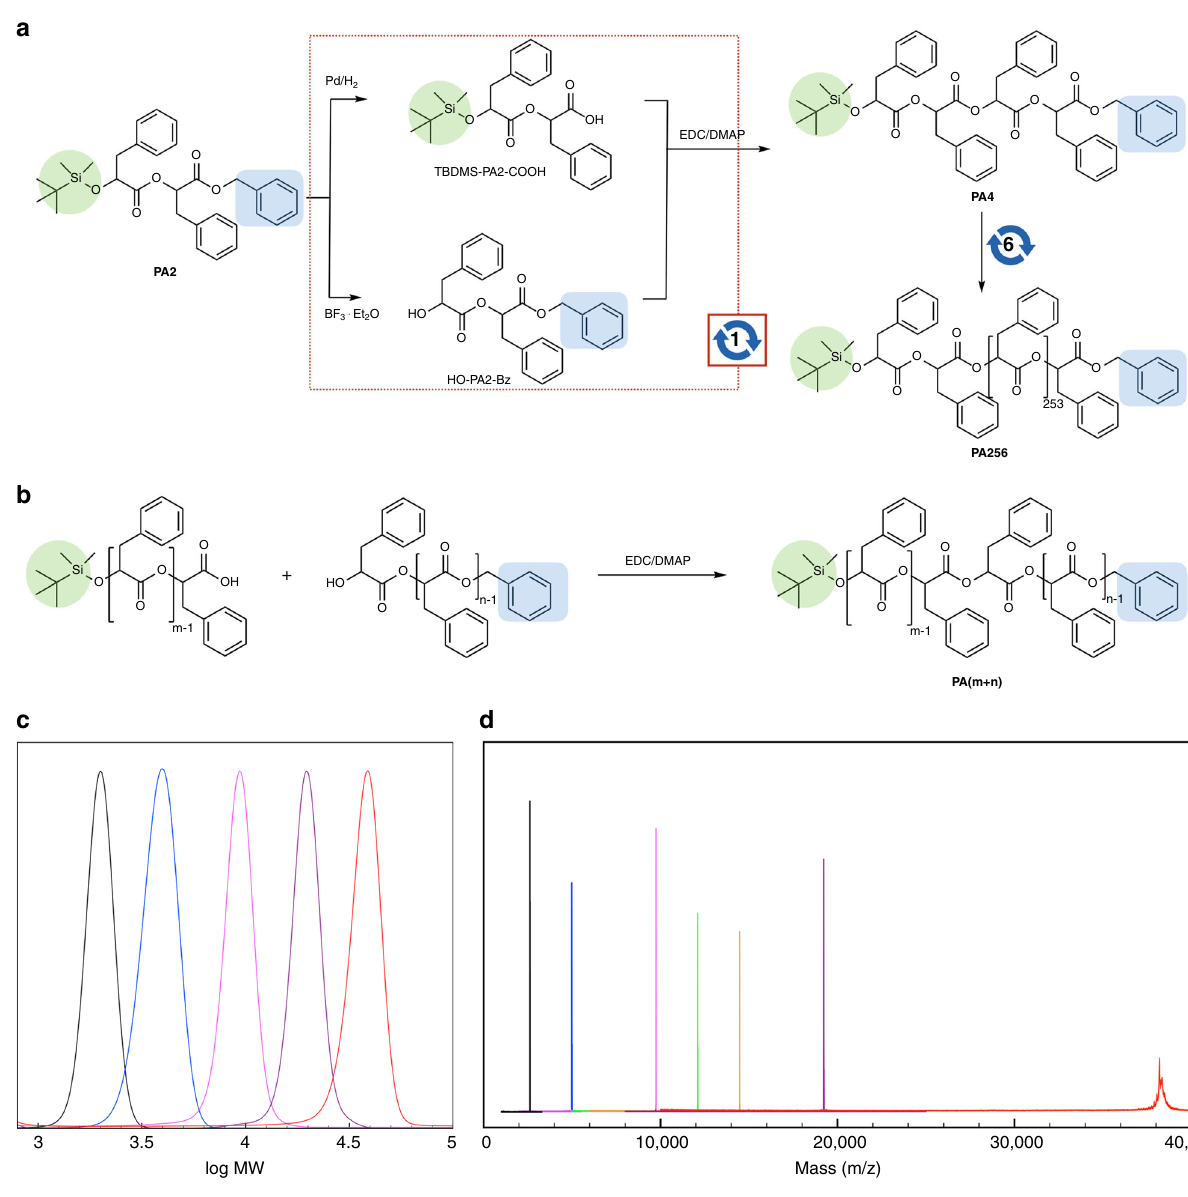
terminus. The other is the x i fragment that contains the original omega group and a new hydroxyl terminus. The mass peaks of c i fragments were found to exhibit low intensities in MALDI-TOF. Therefore, the peaks corresponding to x i fragments were used for sequencing. For last eight residues, a fragment of PcL (mass to charge ratio, 2703.9 Da) was used as a parent ion for the analysis by tandem mass.